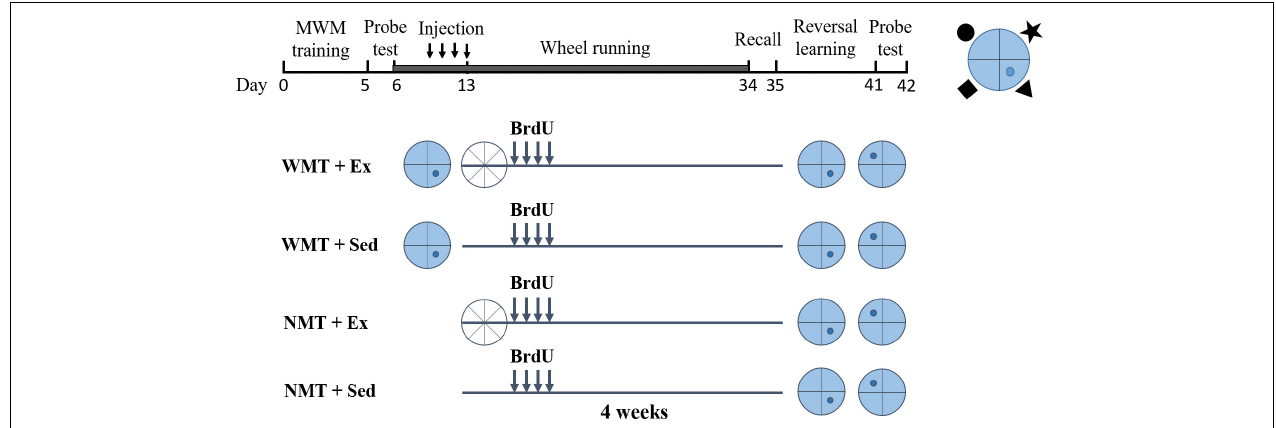
FIGURE 1 | Experimental timeline. Two groups of young adult mice with memory traces (WMT) were trained in the Morris water maze (blue circles with the platform location indicated in darker blue dot), whereas the other two groups with no memory traces (NMT) were not trained but remained in their cages. Half the mice were then subjected to 4 weeks of wheel running exercise (Ex; white circles) and the other half remained sedentary (Sed) in their home cage. To label newborn neurons, 5-bromo-2 (cid:48) -deoxyuridine (BrdU) was injected twice daily into all mice during the last 4 days of the first week of exercise. Following 4 weeks of exercise, a probe test was conducted in the Morris water maze to test recall, followed by a reversal learning task in the maze and a final probe test to examine new memory. A scheme of the position of the platform with respect to the cues used in Morris water maze was shown in the top right corner (the black shapes were the